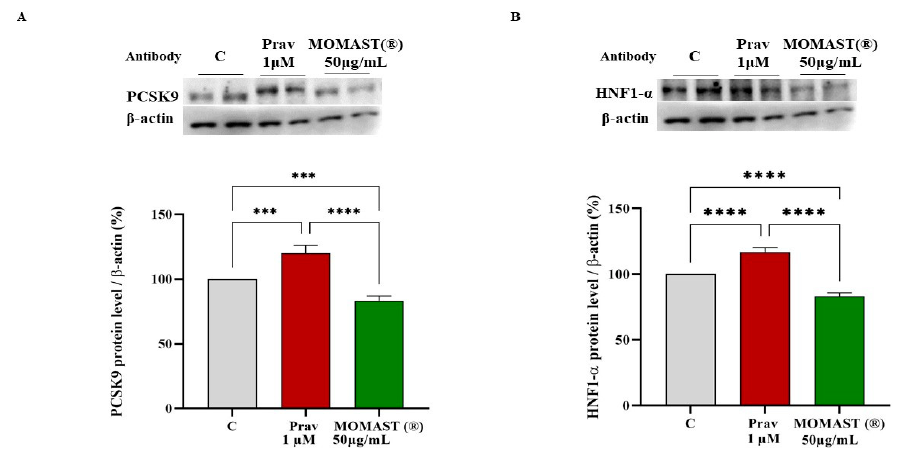
Figure 5. Impact of MOMAST ® on PCSK9 (Panel ( A )) and the HNF1- α (Panel ( B )) protein levels. Bars